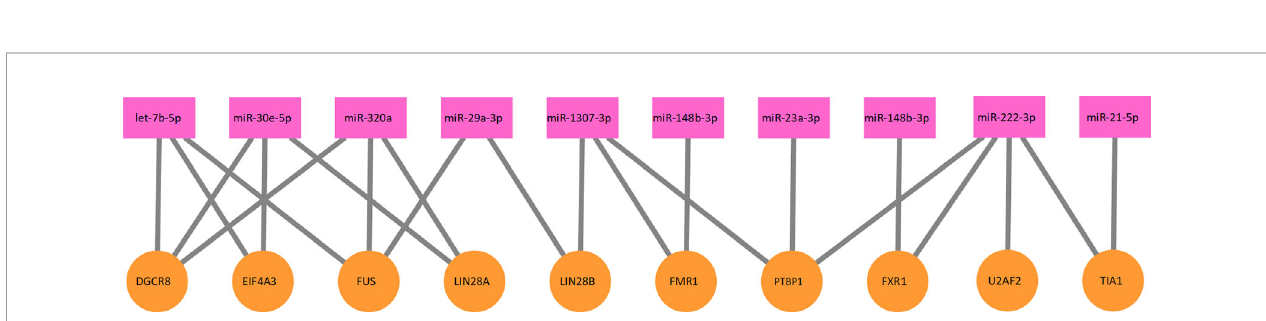
FIGURE 2 | A part of the protein – miRNA interaction network. Ten proteins and 10 miRNAs formed this part of the interaction network. The network is a bipartite graph. One protein can interact with multiple miRNA and vice